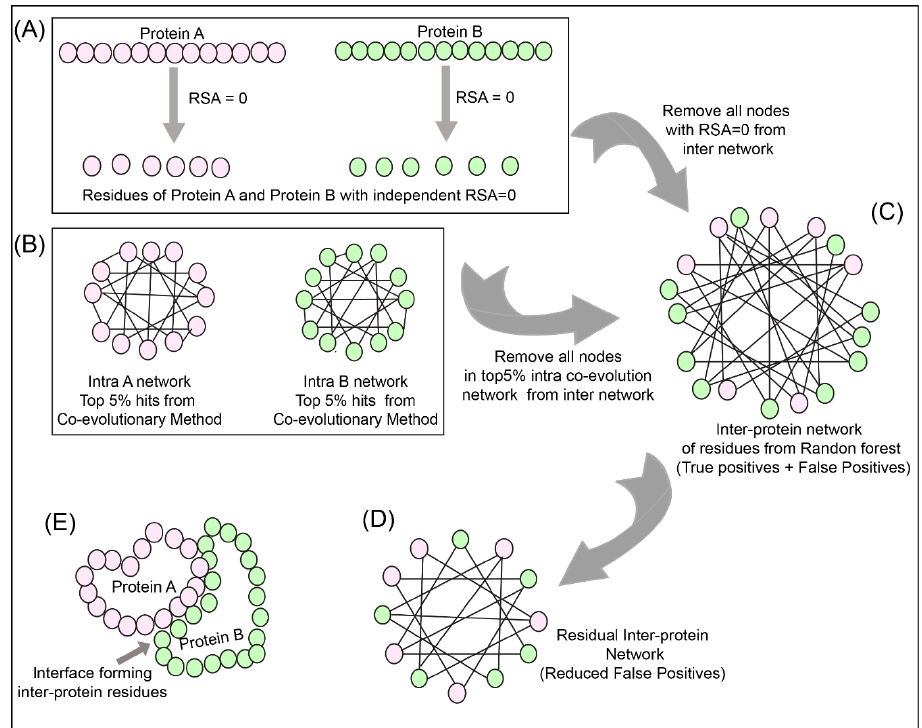
Figure 3. Network analysis of intra and inter-protein contacts. ( A ) Extraction of residues with relative solvent accessibility (RSA) = 0 for Protein A and B. ( B ) Intra-contact prediction for Protein A and B (top 5% co-evolving residue pairs). ( C ) Predicted inter-protein network from Random Forest classifier. ( D ) The false-positive inter-protein residue pairs obtained from the Random Forest classifier are reduced by removing nodes having RSA = 0 for Protein A and B, as well as the top 5% co-evolving intra-protein residues of Protein A and B. ( E ) Analysis of the inter-contact from residual network onto the structure of Protein A and